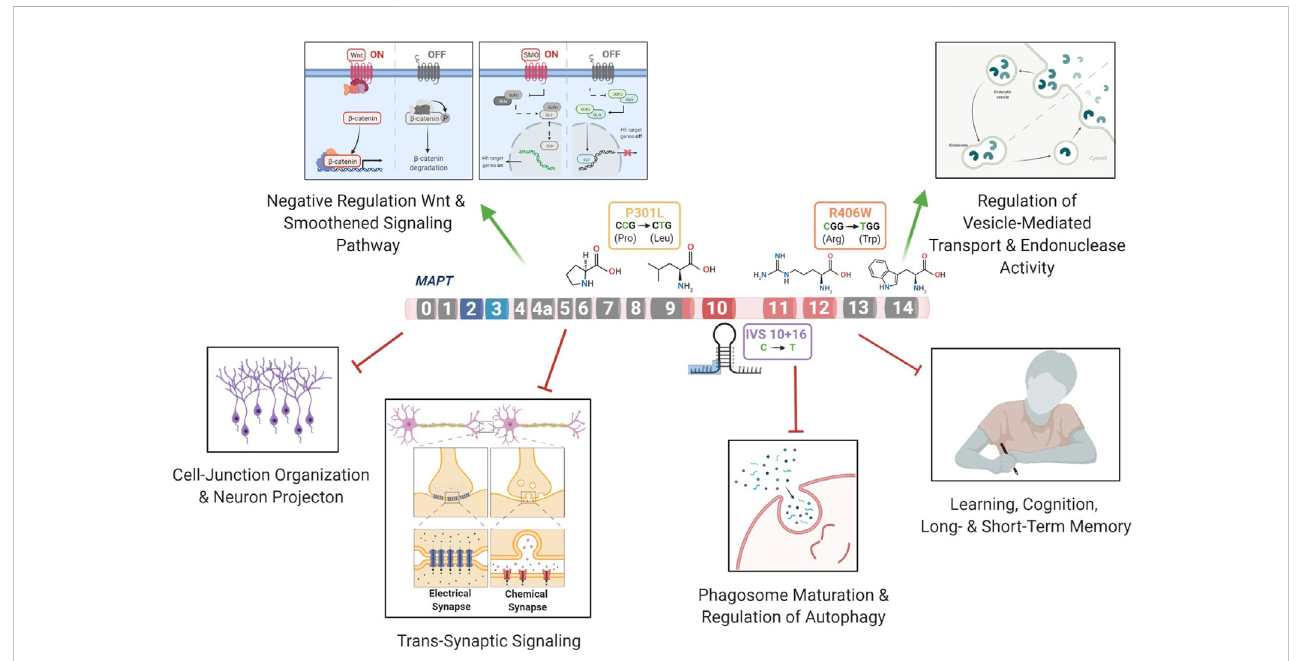
FIGURE 6 MAPT mutations lead to changes in the regulation of pathways related to